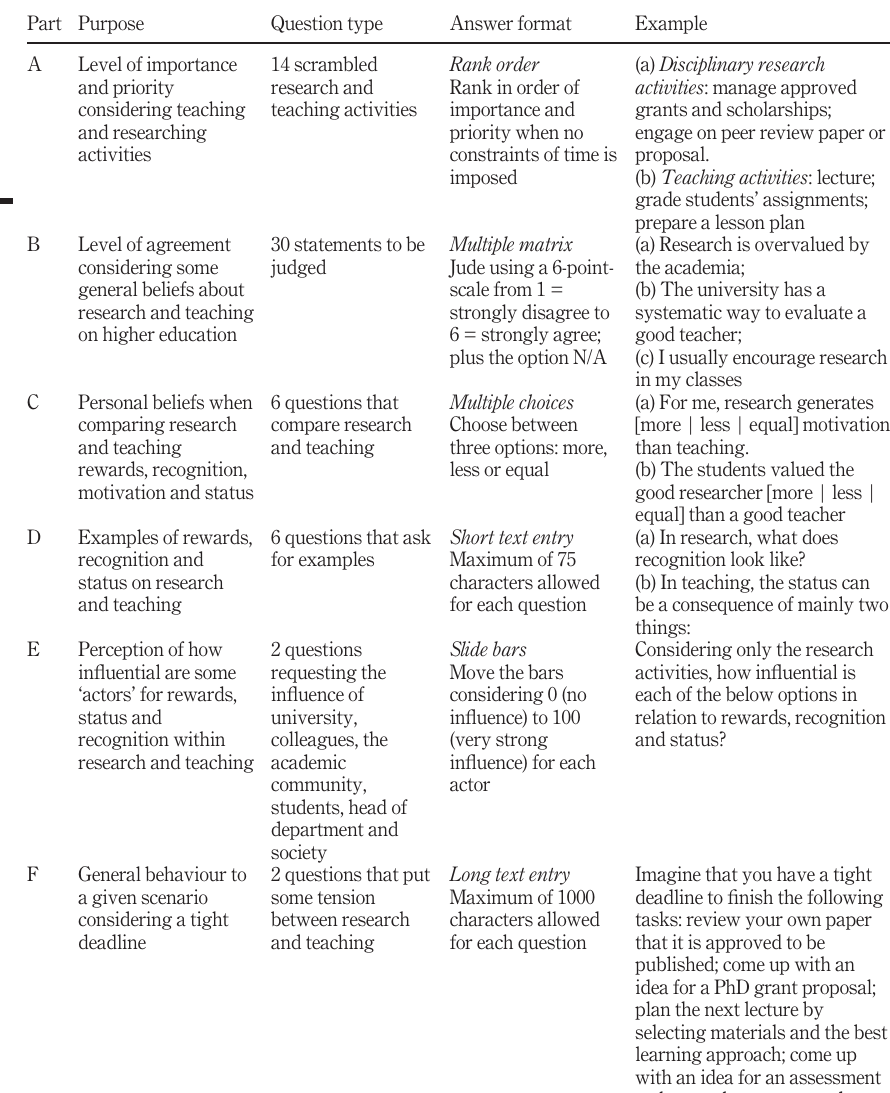
Table I. Questionnaire